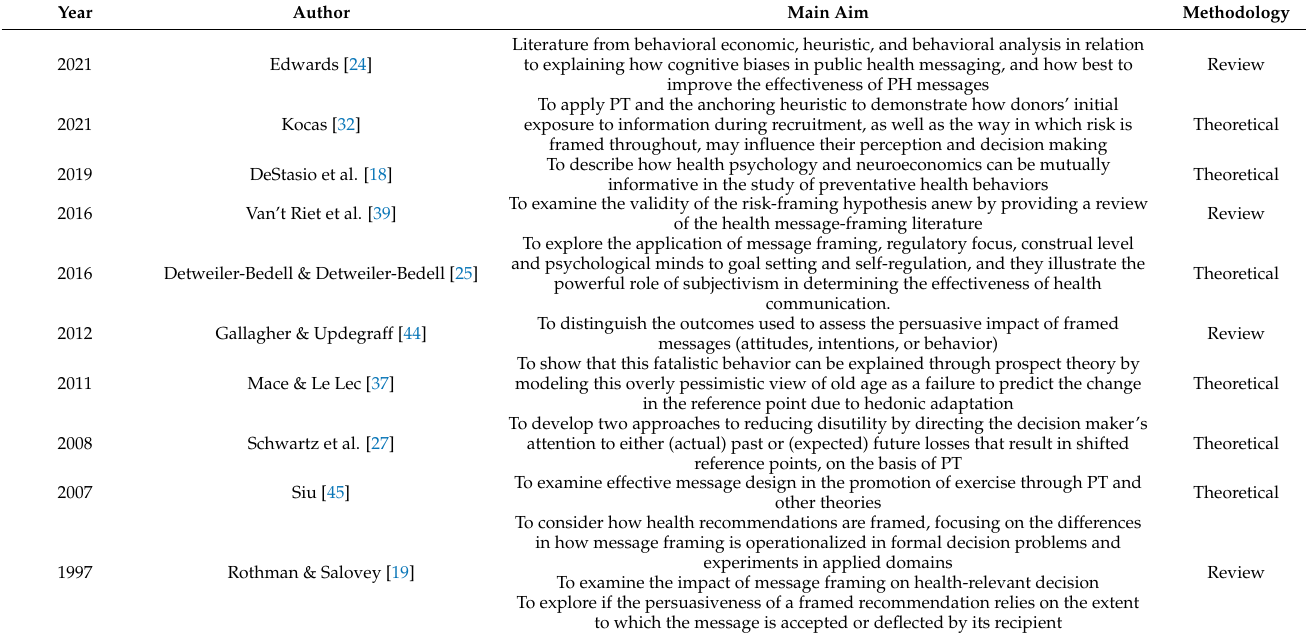
Table A1. Non-empirical articles included in the systematic